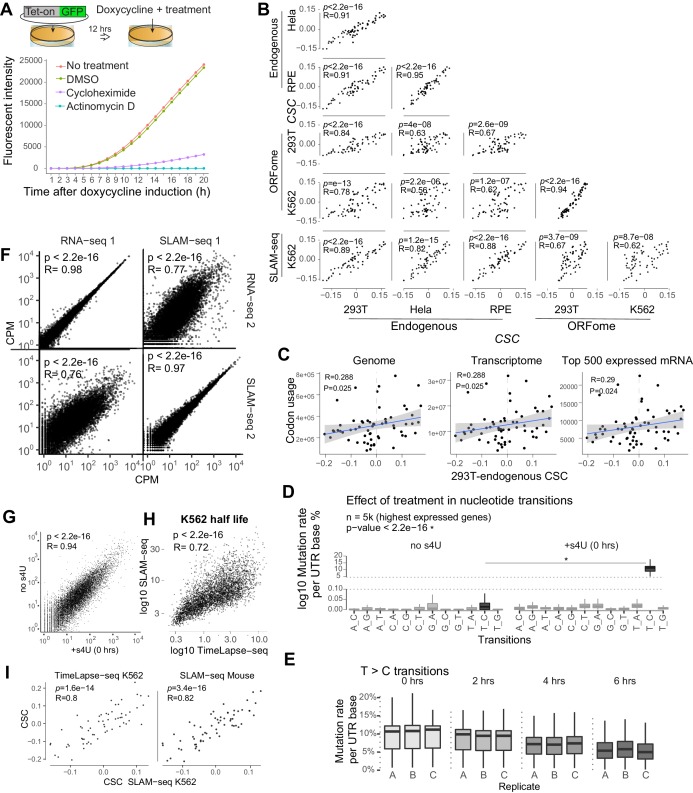
Human and mouse mRNA decay correlate with codon composition in human lines.(A) Drug condition analysis for actinomycin D and Cycloheximide in 293T cells. Transfected cells with tet-on GFP, were treated with different drugs and induced with Doxycycline at time 0 hr. Then cells were under time-course fluorescent detection. Cycloheximide (2 μg/ml) repressed translation, with low GFP level, Actinomycin D(5 μg/ml) blocked transcription, with no GFP expression detected. (B) Scatter plot for CSC scores from different human cell lines and/or methods measuring mRNA decay. (C) Scatter plots showing 293T endogenous CSC scores comparing to codon usage calculated from the genome, transcriptome (each gene with the weight of RPKM) or the top 500 highly expressed genes. Spearman correlation is used, p value and R value is indicated. (D) Boxplot showing the ratio of nucleotide transition without and with s4U treatment using the top five thousand expressed mRNA, only T_C transition gets significant increase after labeling, indicating the SLAM-seq labeling works. Wilcox rank sum test is used, p.value indicated. (E) Boxplot showing the T to C transition in each triplicate over time. The ratio decreased with time for the chasing period. (F) Scatter plot for mRNA-seq with regular RNA-seq and SLAM-seq in duplicates. Pearson correlation and P-values indicated. (G) Scatter plot for mRNA level with and without s4U treatment, s4U treatment did not influence gene expression. Pearson correlation and P-value indicated. (H) Scatter plot showing mRNA half-life of endogenous genes in K562 cell measured with two different methods, TimeLapse-seq (Schofield et al., 2018), and our SLAM-seq. Pearson correlation and p-value indicated. (I) Scatter plot showing CSC scores from our SLAM-seq data in K562 cells, published dataset for TimeLapse-seq in K562 (Schofield et al., 2018), and published SLAM-seq data in mouse embryonic stem cell (Herzog et al., 2017). Pearson correlation and p-value indicated.